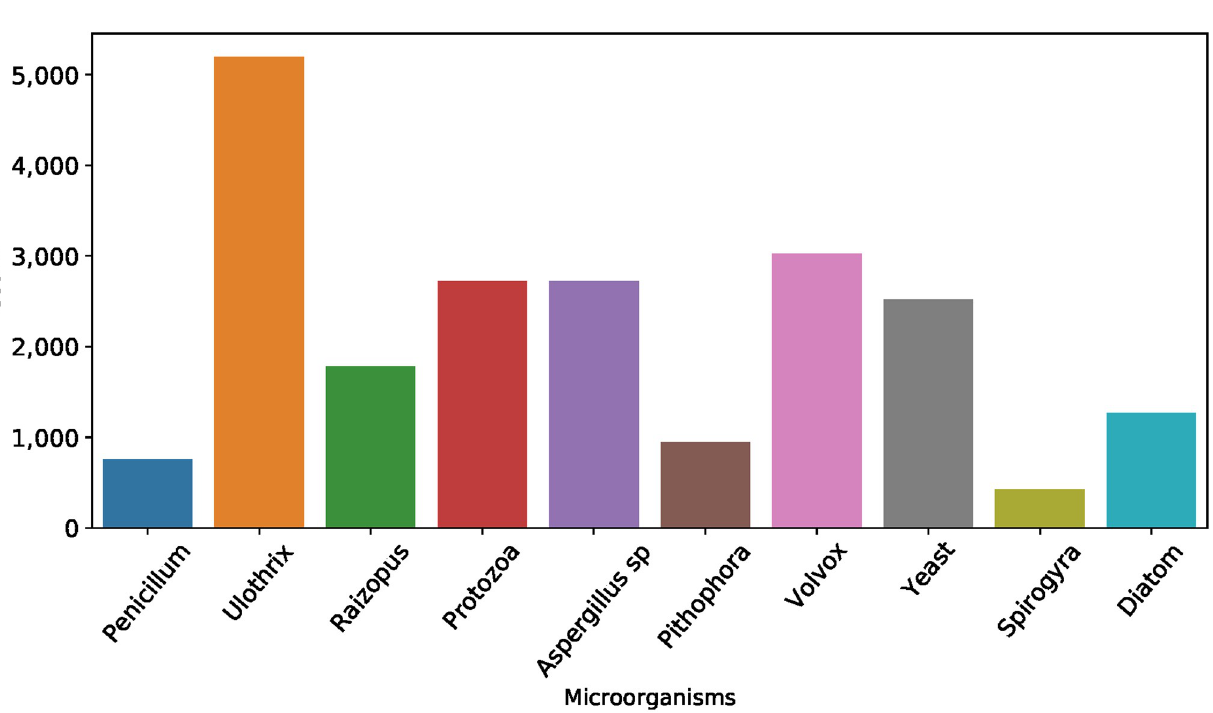
Fig 2. The bar chart-based frequency analysis of each microorganism target label showing the number of samples in each class.